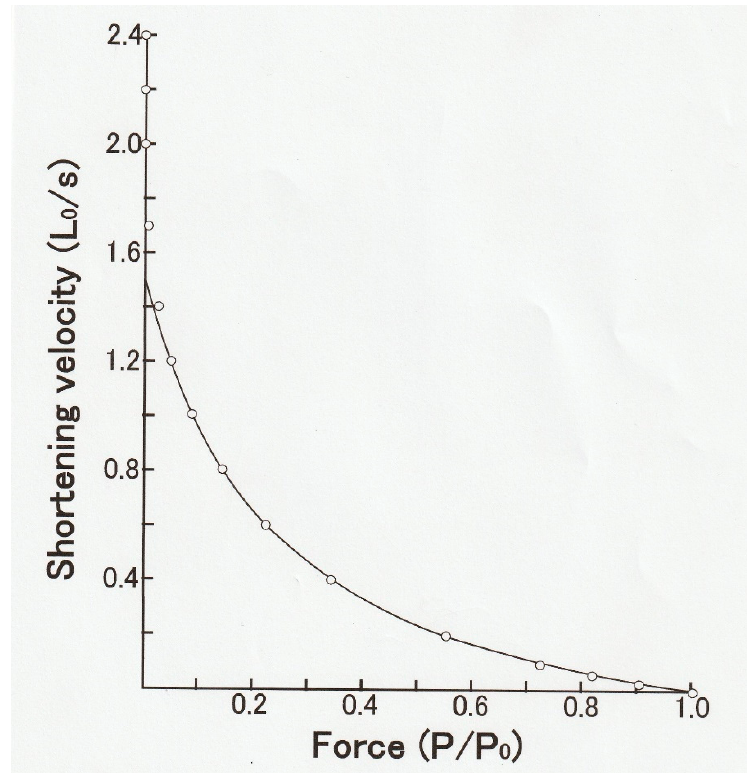
Figure 3. The force–velocity ( P–V ) relation of a whole frog sartorius muscle obtained during an afterloaded twitches at 0 °C. The P–V curve fits part of rectangular hyperbola, so that the relation between P and V are expressed as ( P + a ) V = b ( Po − P ). From Ref. [1].